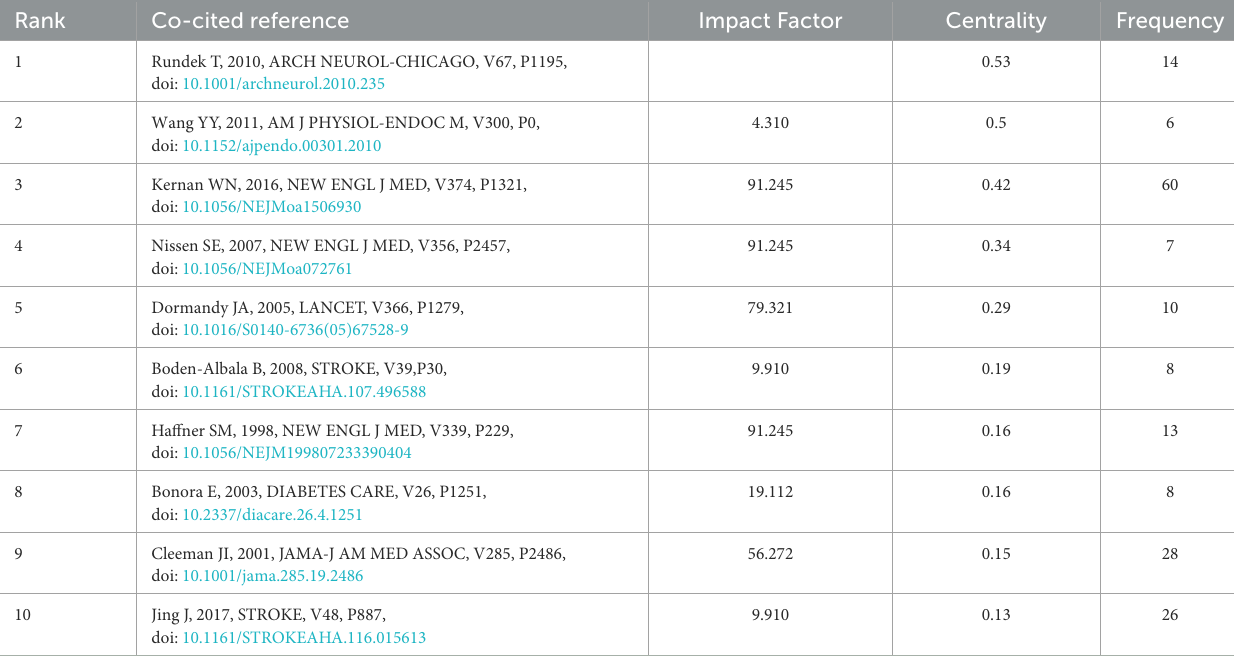
TABLE 4 Top 10 co-cited references with the highest centrality on insulin resistance and ischemic cerebrovascular disease. Rank Co-cited reference Impact